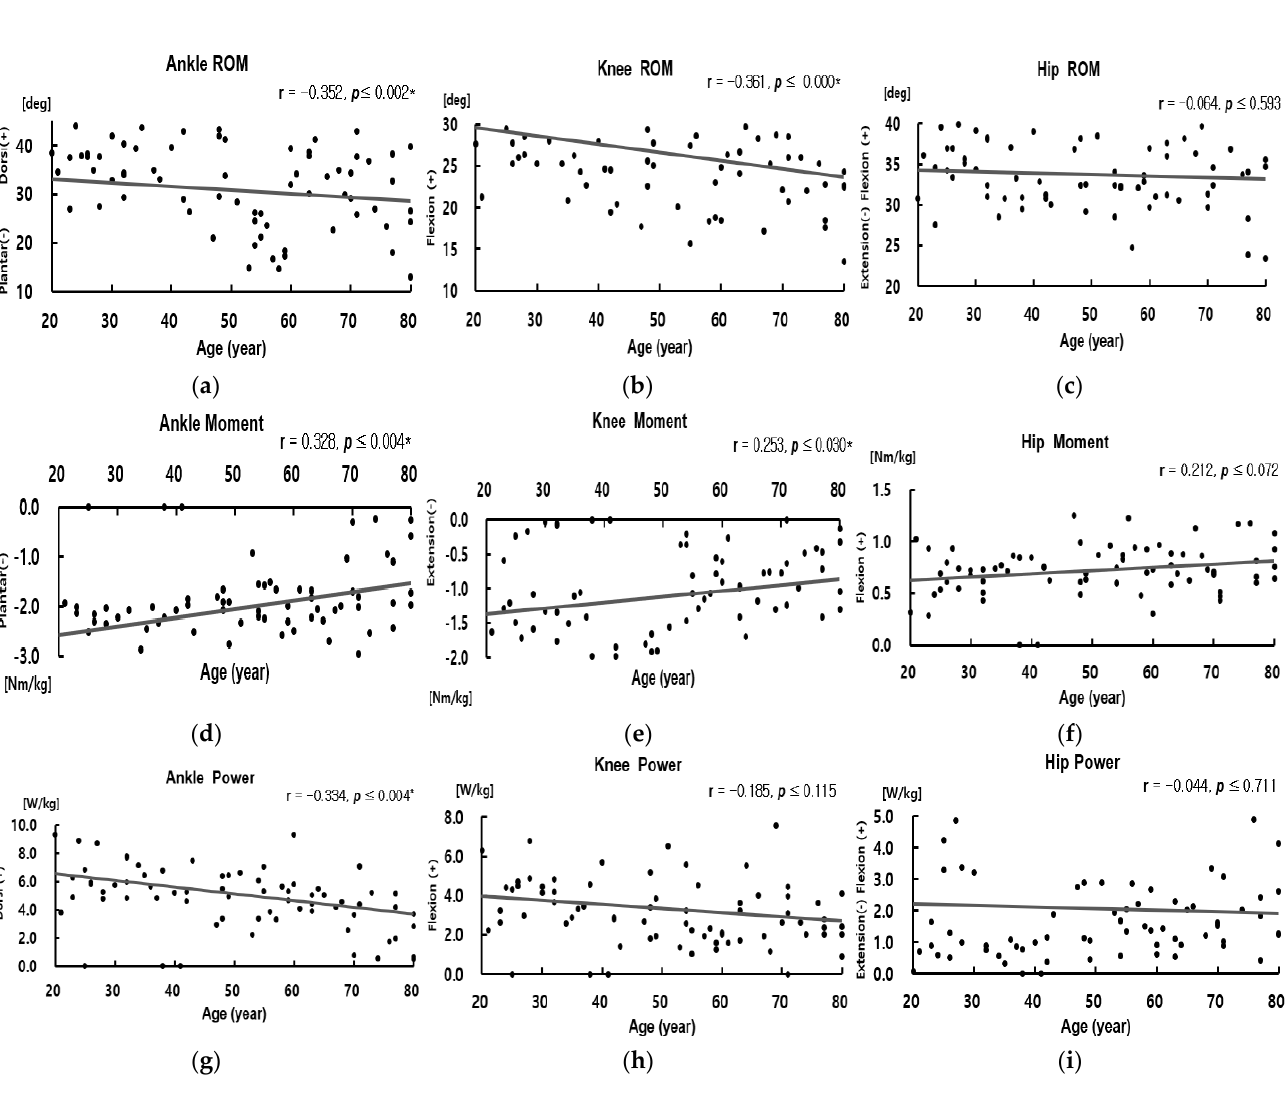
Figure A2. Correlations between age and impact and running characteristics. ( a ) Stride time, ( b )